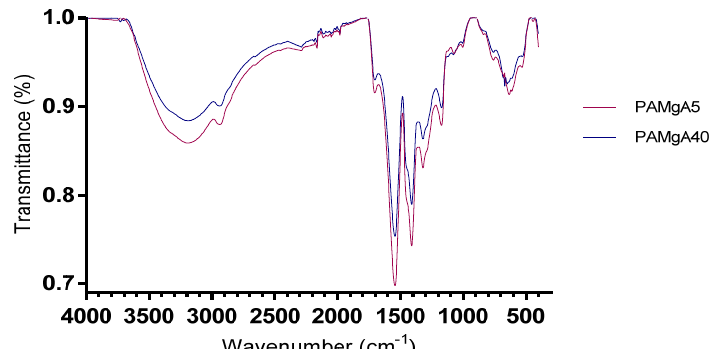
Figure 2. FT-IR spectrum of PAMgA 5 and PAMgA 40.